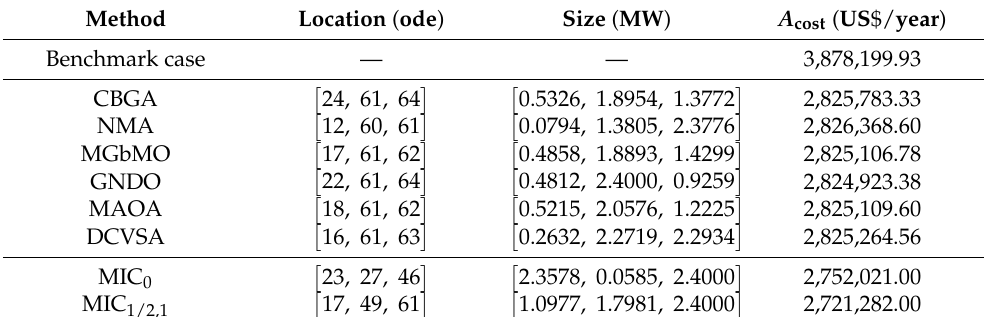
Table 5. Numerical performance of the metaheuristic optimizers and the proposed MIC model in the IEEE 69-bus